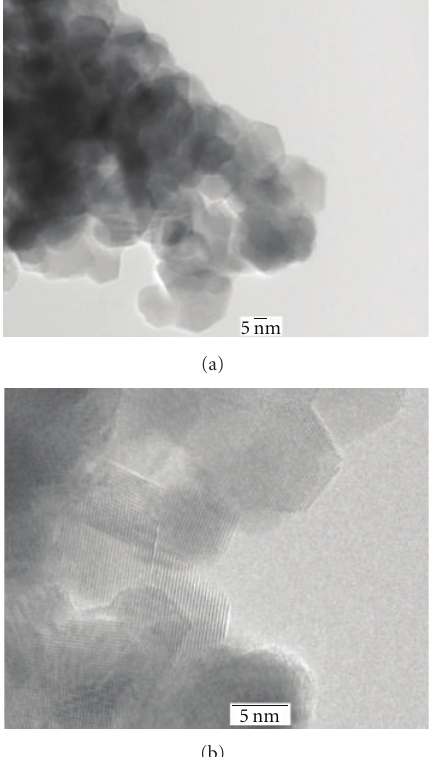
Figure 6: Evidence of agglomeration in RuPd sulfided for 24 h (a) compared to 4h